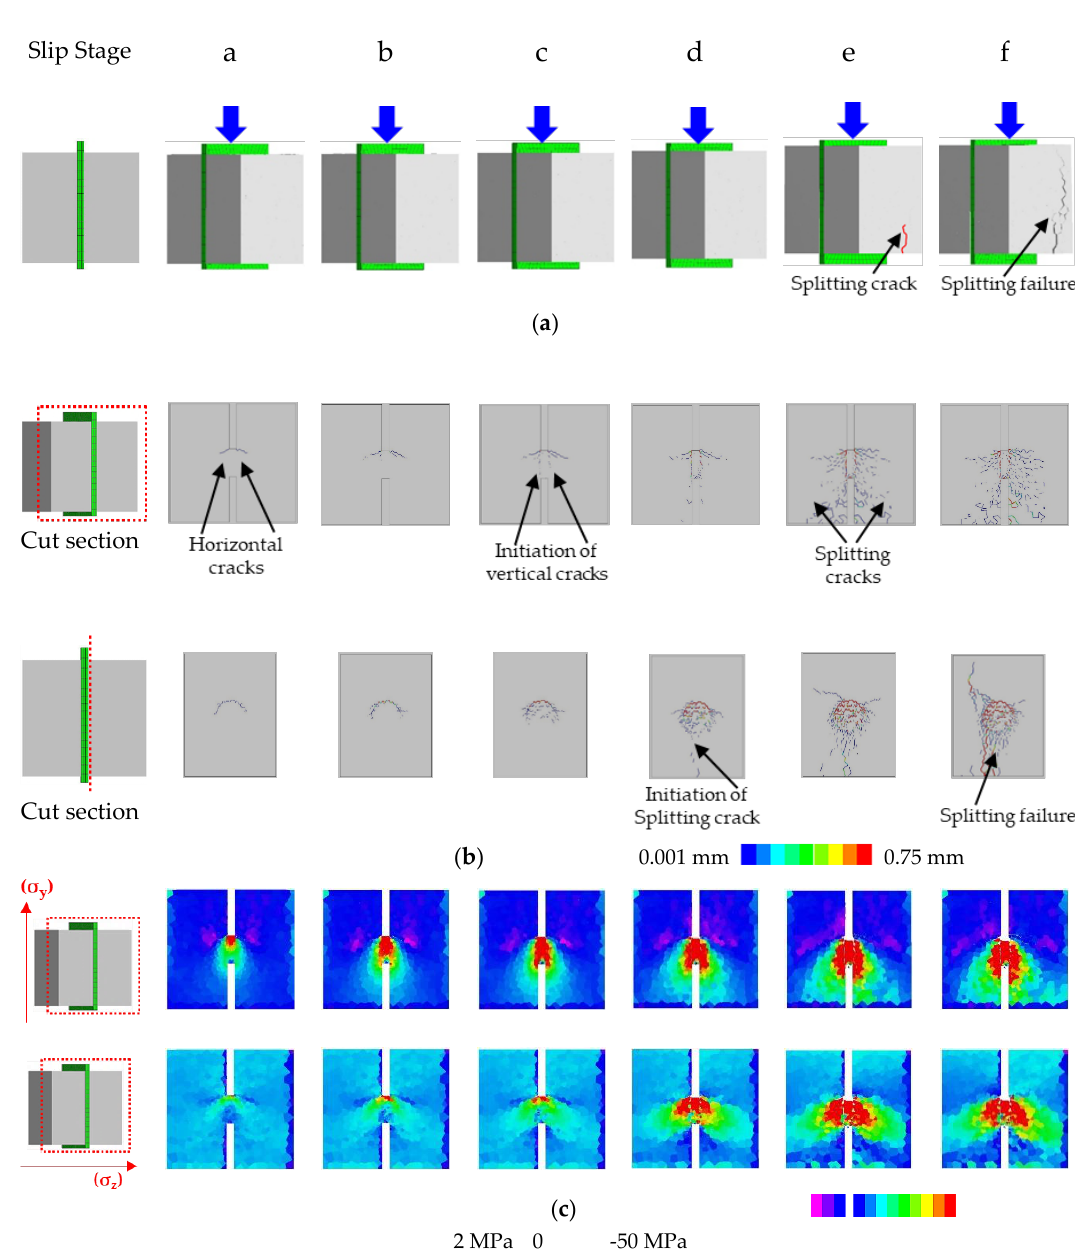
Figure 12. Detailed failure process and mechanism for high lateral pressure case: ( a ) Surface deformed behaviors ( × 5); ( b ) Internal crack patterns at cut sections perpendicular and parallel to the thickness of the steel plate; ( c ) Normal stress distribution along with height (y-axis: direction corresponding to the application of push-out force) and width (z-axis: direction corresponding to the application of lateral pressure) at the cut section perpendicular to the thickness of the steel